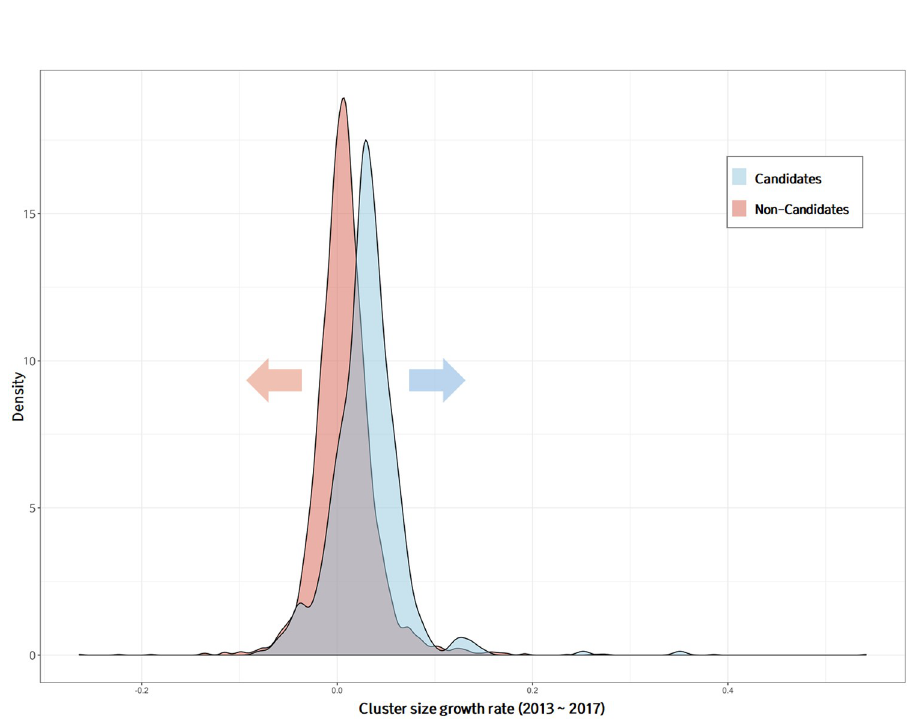
Fig 12. Comparison of growth rate distribution of technology clusters with and without high growth potential over last 5 years.